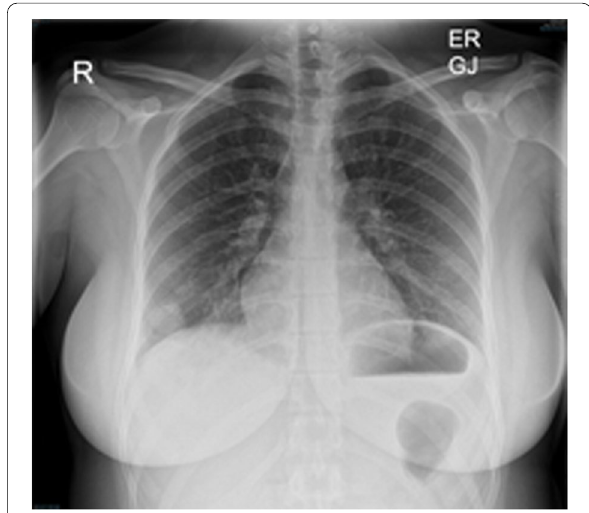
Fig. 1 Chest X-ray showed well defined rounded opacity in right lower zone likely representing consolidation